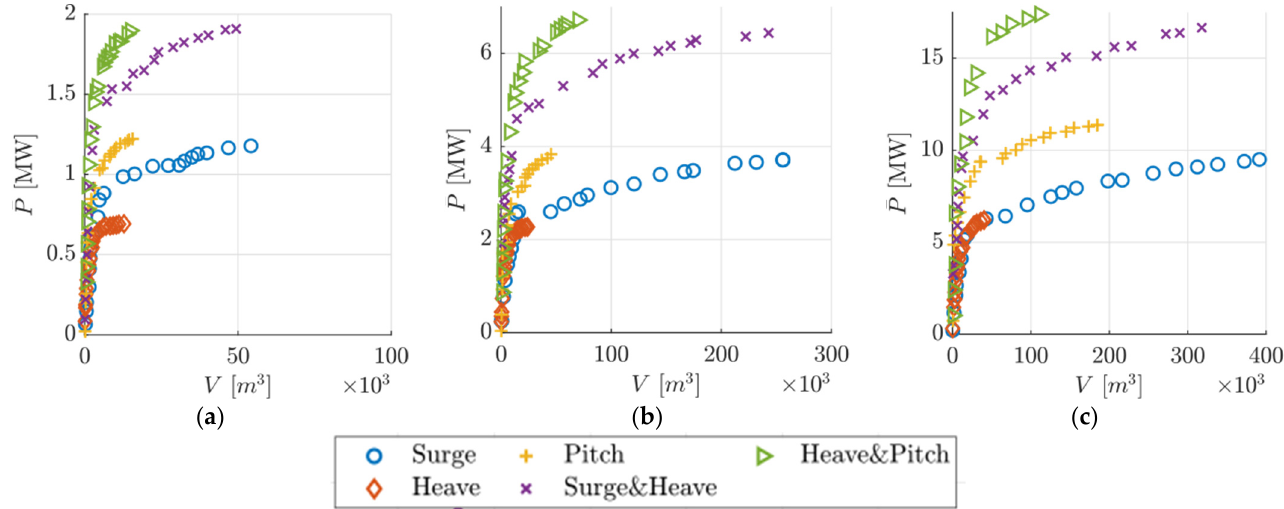
Figure 4. Example fundamental relationships found for a cuboid absorbing power in different modes of motion in ( a ) low, ( b ) medium and ( c ) high resource levels. Note that here P refers to the mean annual power, and V to the submerged volume, and the y-axis scales are different between sub plots.